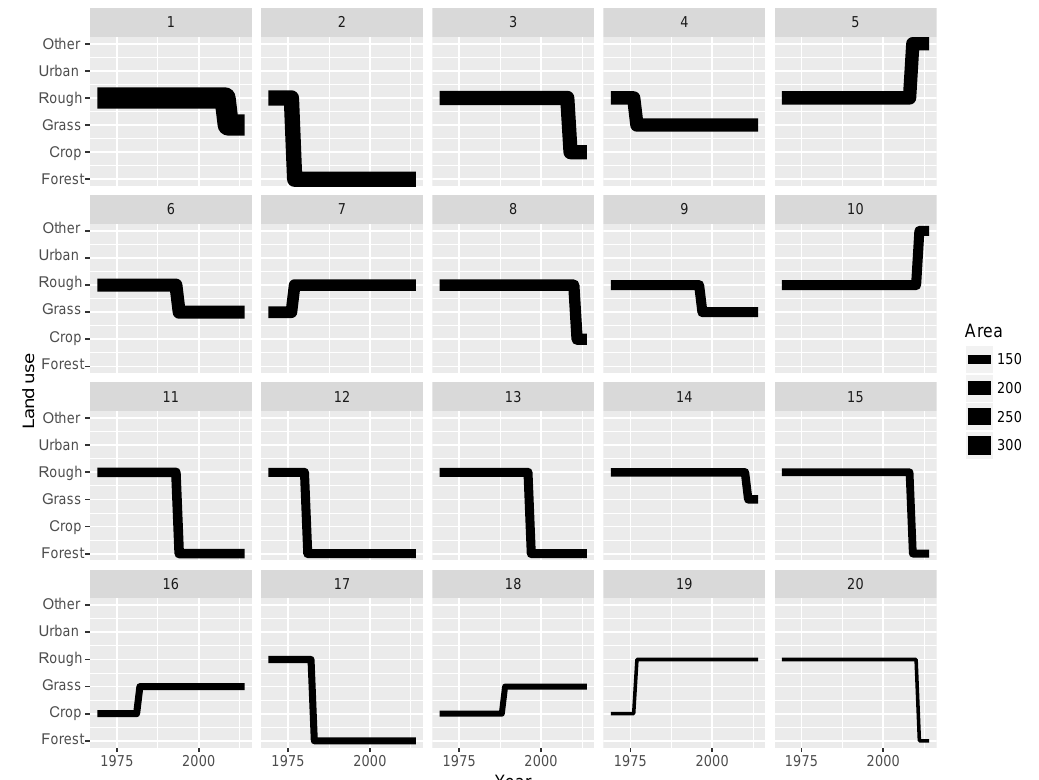
Figure 9. Trajectories of the 20 land-use vectors in the posterior U with the largest areas (excluding the six vectors which show no change). Line thickness is proportional to the frequency of (or total area occupied by) the